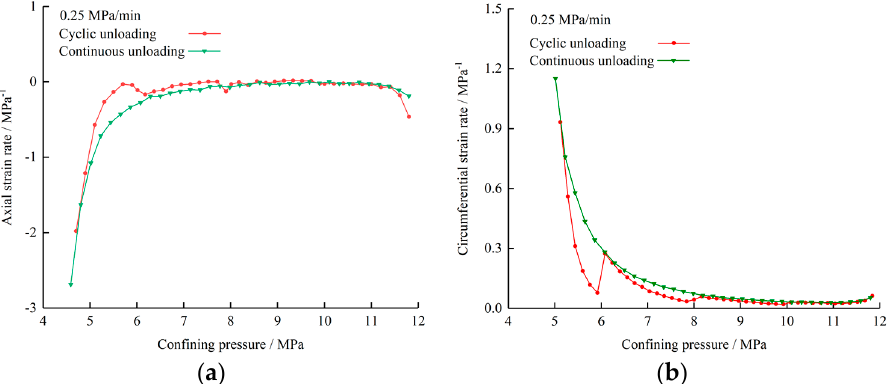
Figure 15. Growth of strain rate under different unloading pattern: ( a ) axial strain rate; ( b ) circumferential strain rate.